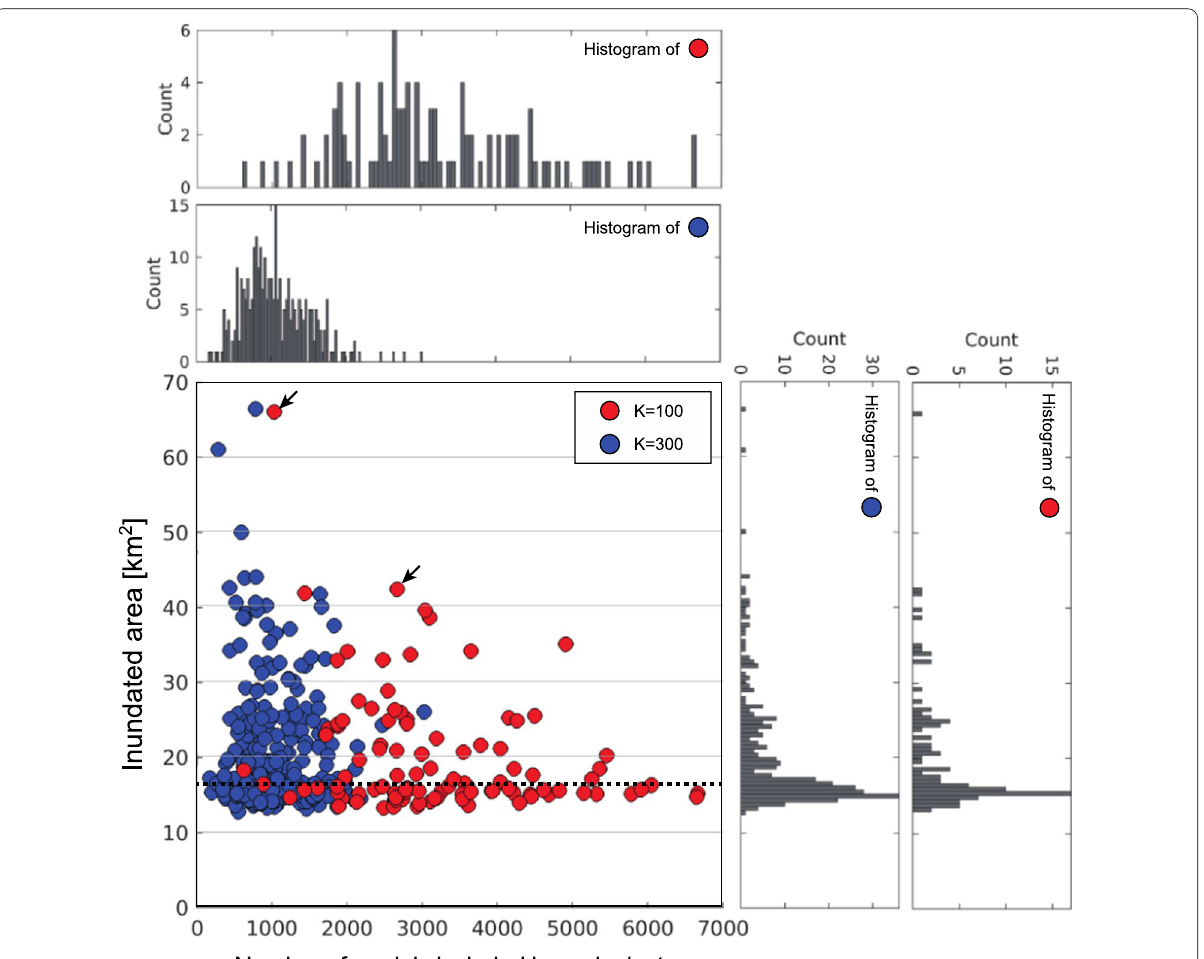
Fig. 10 Tsunami inundation calculation results for multiple tsunami scenarios. Correlation between the number of models included in each cluster and the tsunami inundation area. The dotted black line indicates the inundation area of assumed model (Fig. 1). The vertical and horizontal axes on the inserted diagrams indicate the frequency distributions. Inserted vectors indicate the scenarios of Fig. 9 (a,